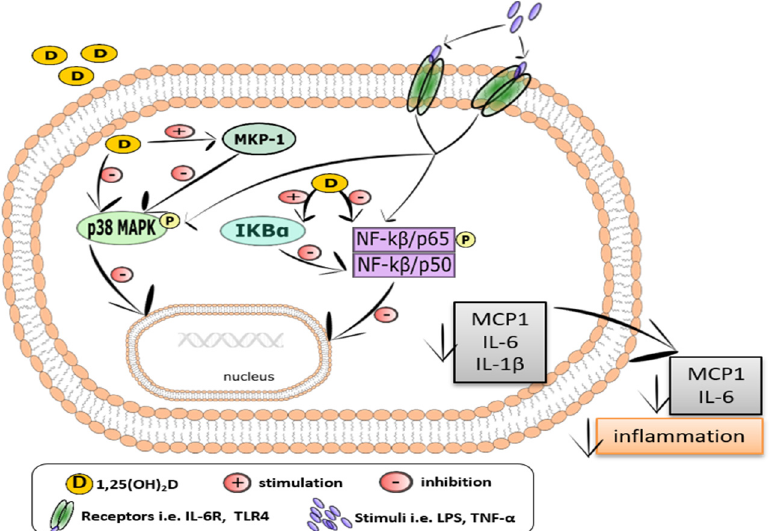
Figure 4. The effect of vitamin D on the MAPK and NF-kB pathways engaged in adipocyte inflammation. NF- κ B is a key transcriptional factor involved in multiple processes, e.g., proliferation but also at the first step in the regulation of the inflammatory response due to controlling the release of antimicrobial molecules, including cytokines and chemokines, also in pre-adipocytes and adipocytes, where vitamin D was found as an inhibitor of the processes NF- κ B- and MAPK-driven. Abbreviations: MKP-1, MAPK phosphatase-1; p38 MAPK, p38 mitogen-activated protein kinase; IKB α , nuclear factor- κ appa B inhibitor alpha; MCP1, monocyte chemoattractant protein 1; IL-6, interleukin 6; IL-1 β , interleukin 1 β ; LPS, lipopolysaccharide; TNF- α , tumor necrosis factor α ; IL-6R, interleukin 6 receptor; TLR4, Toll-like receptor 4. ↑ increase; ↓ decrease.